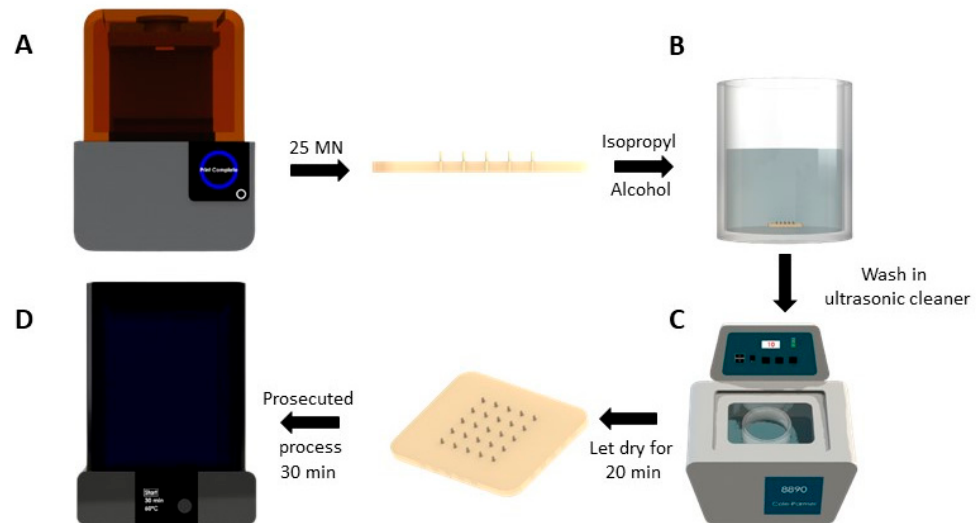
Figure 4. MN patch manufacturing process. ( A ) MN patch manufacturing in the Form 2 printer, ( B ) MN patch immersed in isopropyl alcohol, ( C ) ultrasonic cleaner to eliminate excess resin, ( D ) cured MN patch in FormCure at 60 ◦ C.